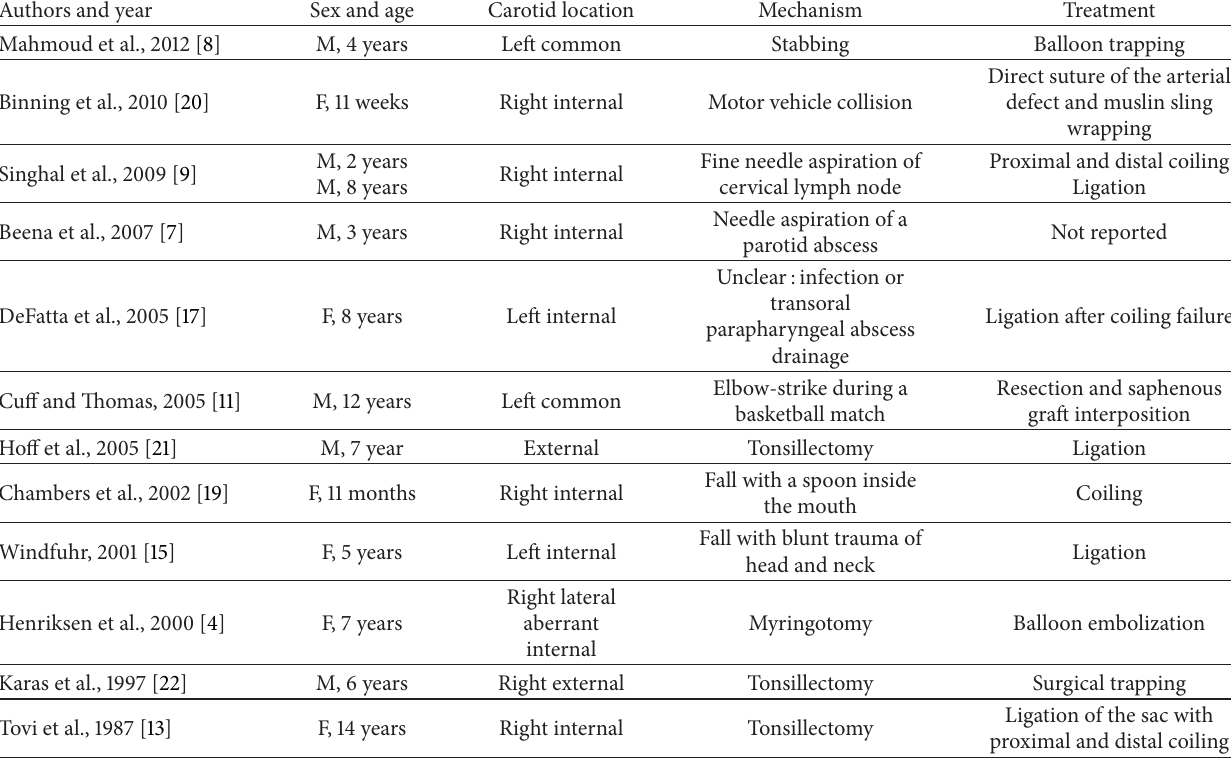
Table 1: Noninfectious carotid pseudoaneurysms reported in the paediatric